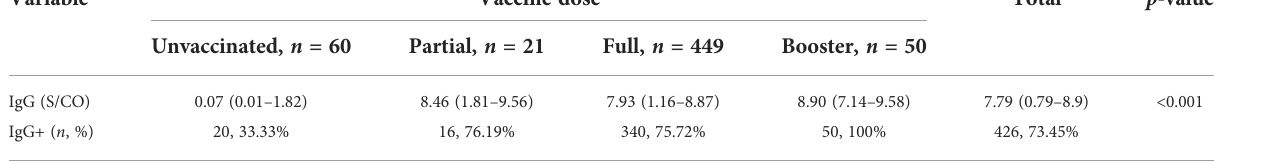
TABLE 2 Antibody levels for different vaccine doses.